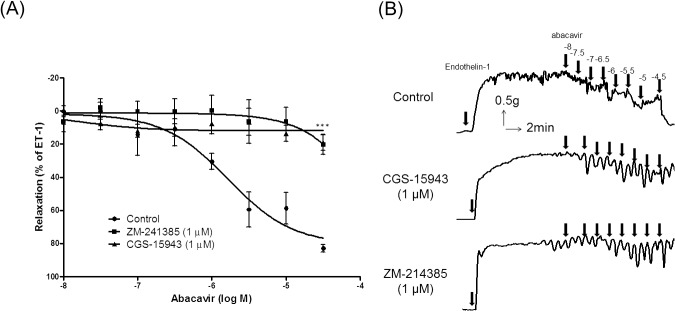
Effects of adenosine receptor antagonists on abacavir-induced relaxation of rat basilar arteries.Rings of rat basilar arteries were treated with CGS-15943 (1 μM) or ZM-241385 (1 μM) for 30 min. Rings without antagonist treatment served as controls. Abacavir-induced relaxation of rat basilar arteries was then measured. (A) Changes in tension were expressed as a percentage decrease in response to contraction caused by endothelin-1 (ET-1; 1–10 nM). (B) Sample trace showing the effects of CGS-15943 and ZM-241385 on abacavir-induced relaxation. Values are means ± S.E.M of four to five sets of experiments and statistical comparisons were made using ANOVA. ***P <0.005 versus control.